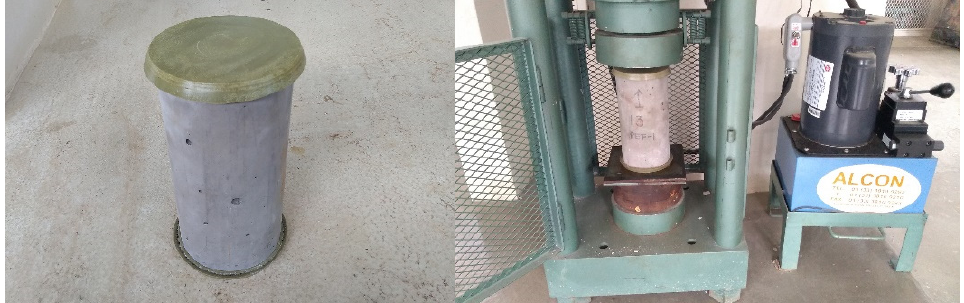
Figure 2. Compressive Strength